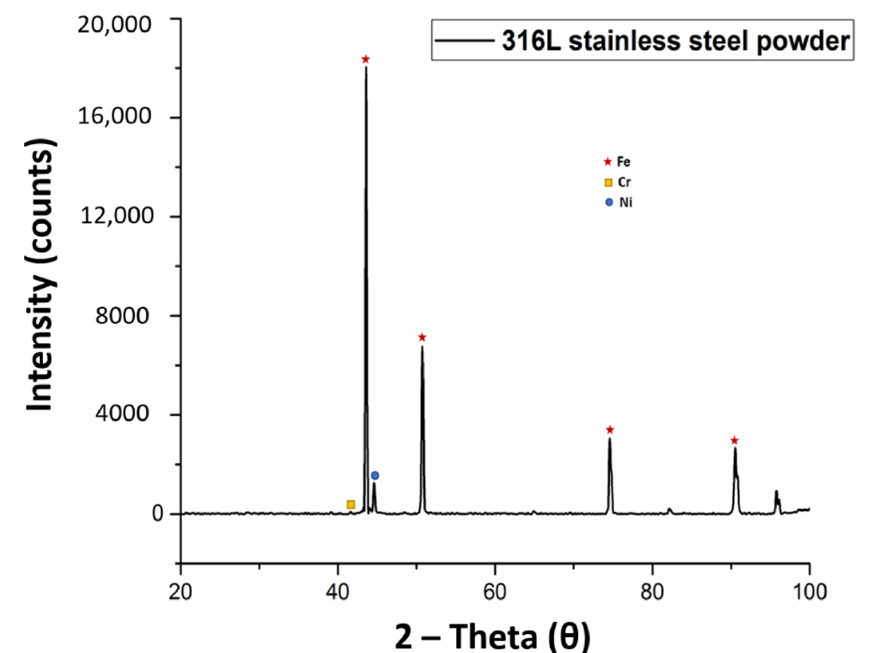
Figure 2. XRD spectrum of 316L stainless steel powder.